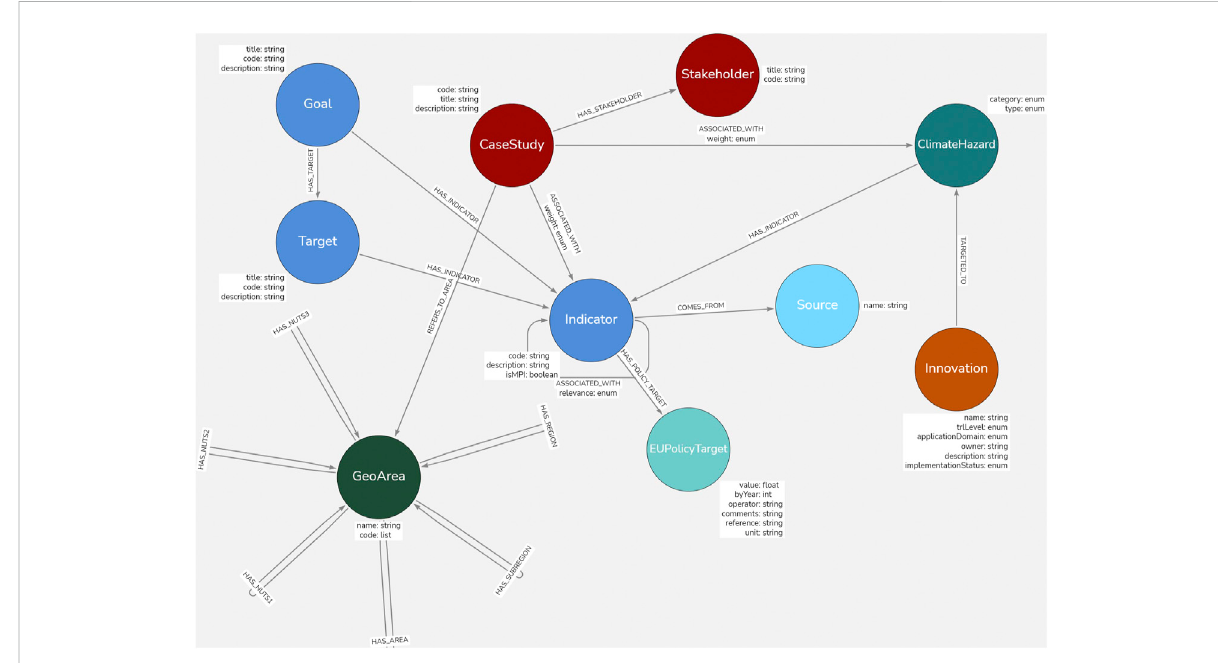
FIGURE 7 Case Studies, Climate related Hazards and Innovations in the